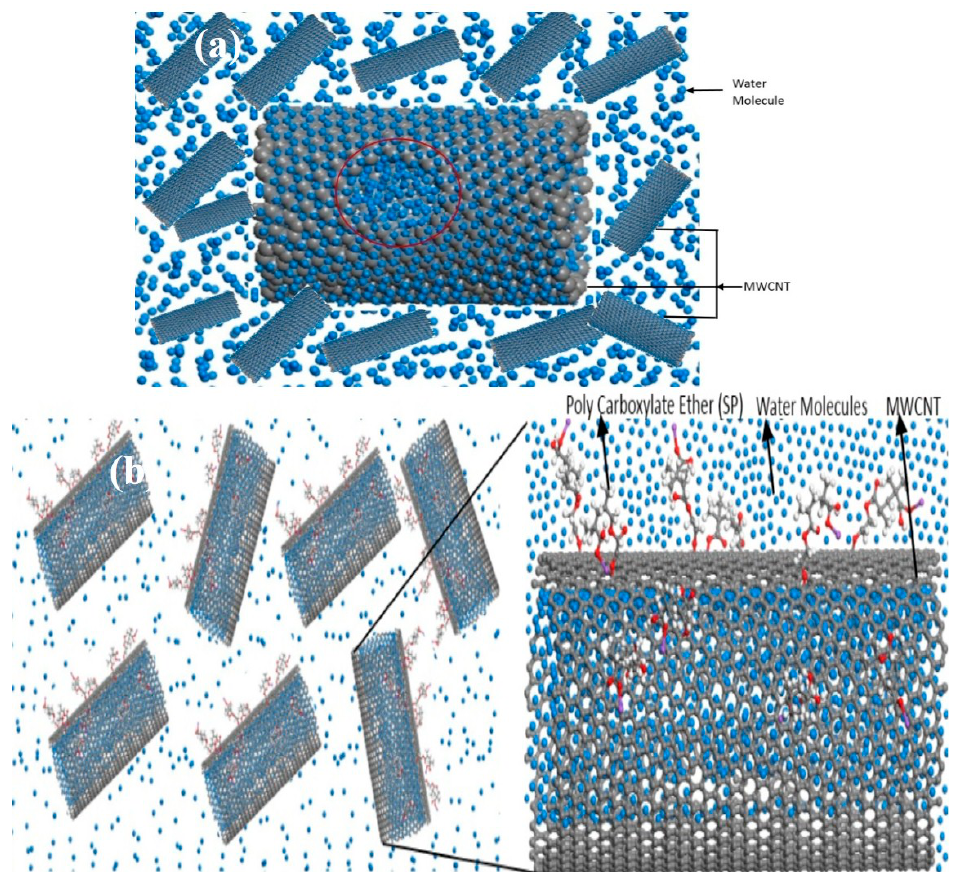
Figure 2. Schematic representation of ( a ) dispersion of CNT in water; and ( b ) surface activated f-CNTs.